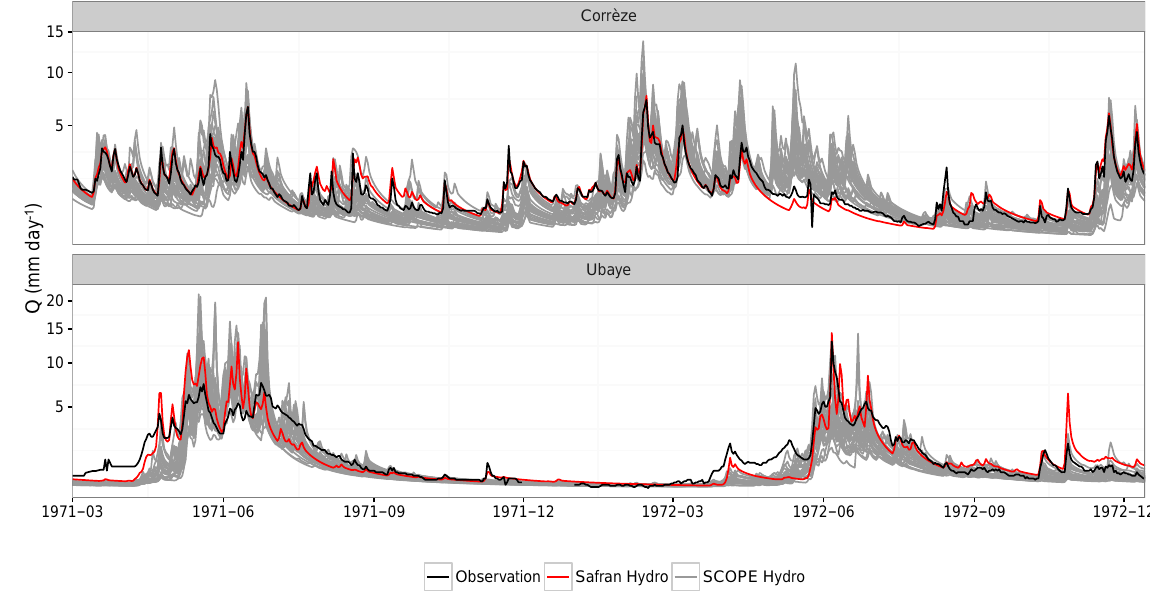
Figure 9. Corrèze and Ubaye daily discharge time series during the extreme low-flow event of 1972, from observations, Safran Hydro, and SCOPE Hydro. Note the different root scales for the y -axis.